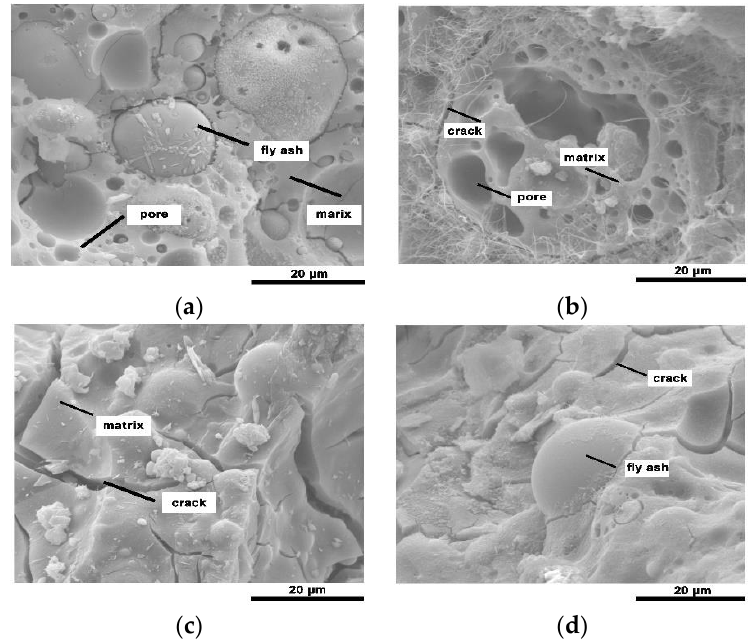
Figure 3. Scanning electron microscope (SEM) images of the obtained geopolymers: ( a ) NaSil-1; ( b ) NaSil-2; ( c ) NaSil-3; ( d ) NaSil-4.